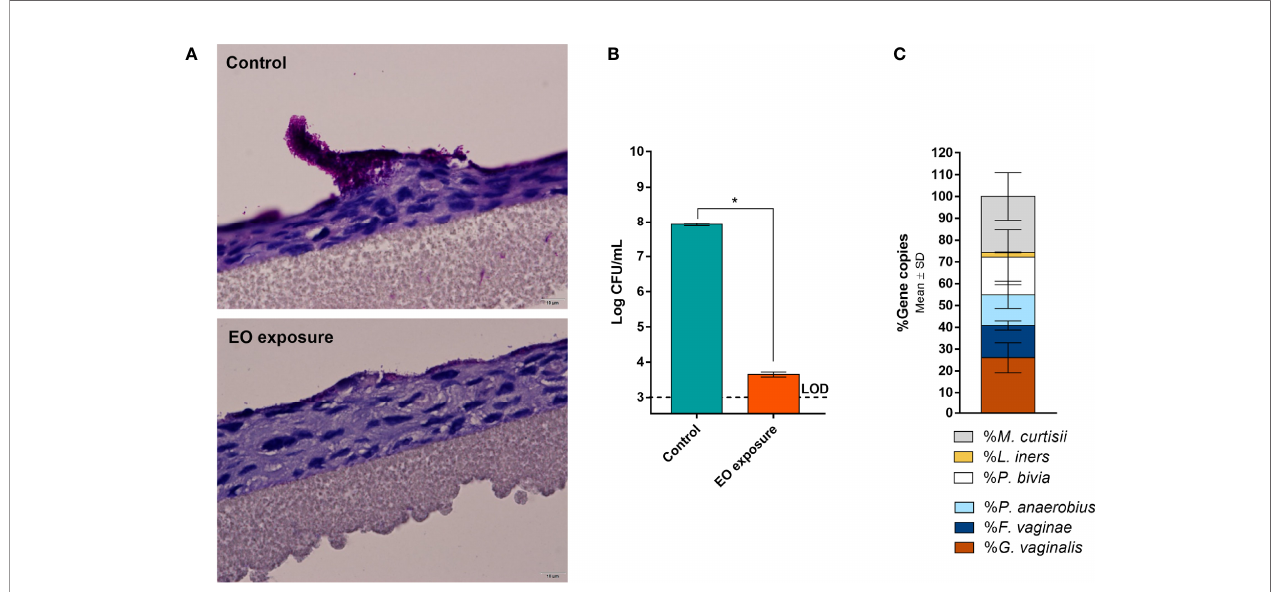
FIGURE 2 | Polymicrobial BV bio fi lm developed on a reconstructed human vaginal epithelium. (A) Periodic Acid-Schiff staining images with the BV bio fi lm before and after EO treatment at 600× magni fi cation. (B) Cells culturability from the control and EO treated bio fi lms as determined by CFU method. (C) Bacterial distribution in the polymicrobial BV bio fi lms as determined by qPCR after extraction of genomic DNA of each bacterial species. *Values are signi fi cantly different for control vs EO- exposed bio fi lms (paired t -test, p < 0.05). Essential oil (EO); Limit of detection (LOD). More examples are shown in Supplementary Material